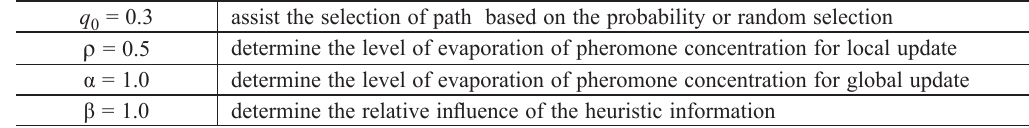
Table 7. Probability & pheromone level of 0–2, 0–3, 0–4 No. of iteration